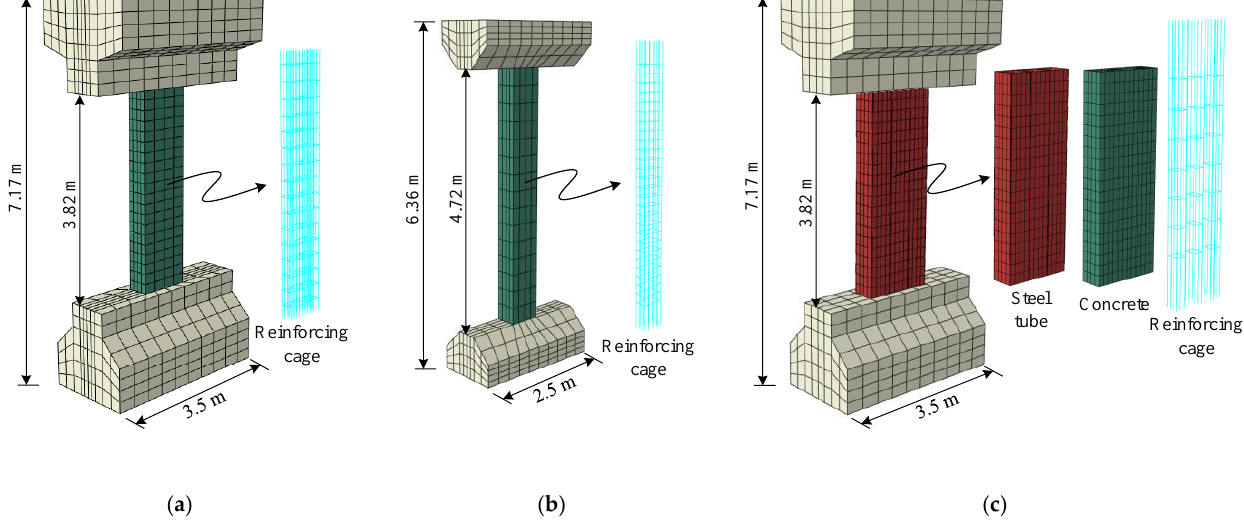
8 of 18 Figure 4. Pushover modes of the central column: ( a ) Mode 1; ( b ) Mode 2. 4.2. FEM and Material Parameters The finite element models based on ABAQUS of the original and the new central columns in pushover analysis are shown in Figure 5, respectively. The calculation ranges of all the models were selected as single-span structures, i.e., 3.5 m for Daikai station and